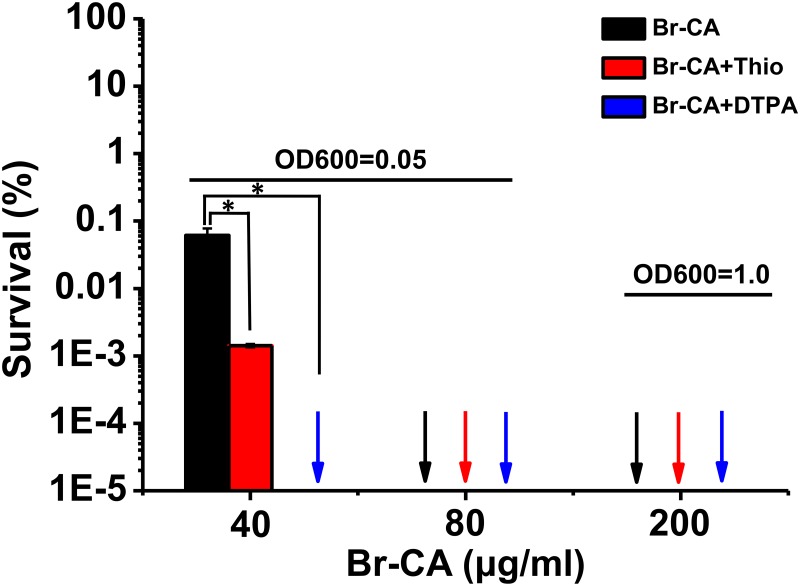
Thiourea and DTPA have no effect on the eradication of persisters by Br-CA.The initial bacterial suspension (OD600 = 0.05 or OD600 = 1.0) was pretreated with or without Thio or DTPA iron chelator and then exposed to different concentrations Br-CA. Cell survival percentage after treatment was calculated based on the colony counts on the LB agar plates. The arrows indicated that cells were killed completely by Br-CA and different colors showed different treatments. Each bar was indicated as the means of three replicates ± standard deviation. Survival post treatment with Br-CA alone at the given concentration were set as the control in the corresponding group. Asterisks indicate a significant difference from their controls (P <0.05).